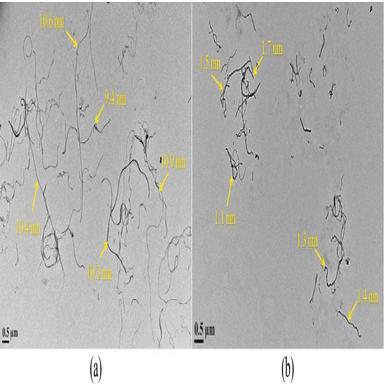
TEM images showing the lengths CNTs: (a) N20; (b) S20.